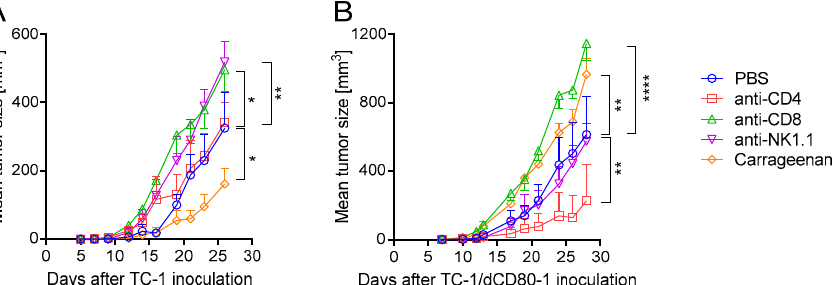
Figure 3. The role of immune cells in tumor growth. CD4 + , CD8 + , or natural killer (NK) 1.1 + cells were depleted by monoclonal antibodies and macrophages by carrageenan in mice bearing TC-1-induced tumors ( A ) or TC-1/dCD80-1-induced tumors ( B ). Statistical analysis indicates a comparison with the phosphate-buffered saline (PBS)-treated group. Bars indicate ± SEM; * p < 0.05, ** p < 0.01, **** p < 0.0001.